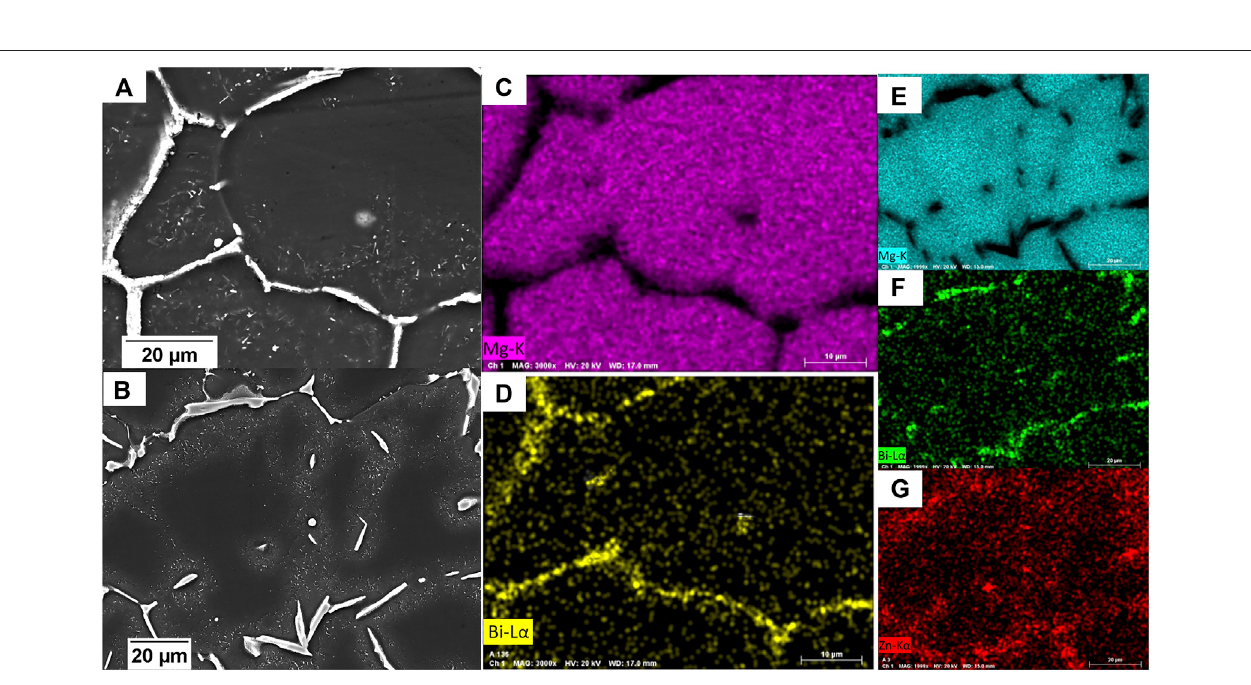
Frontiers in Materials |